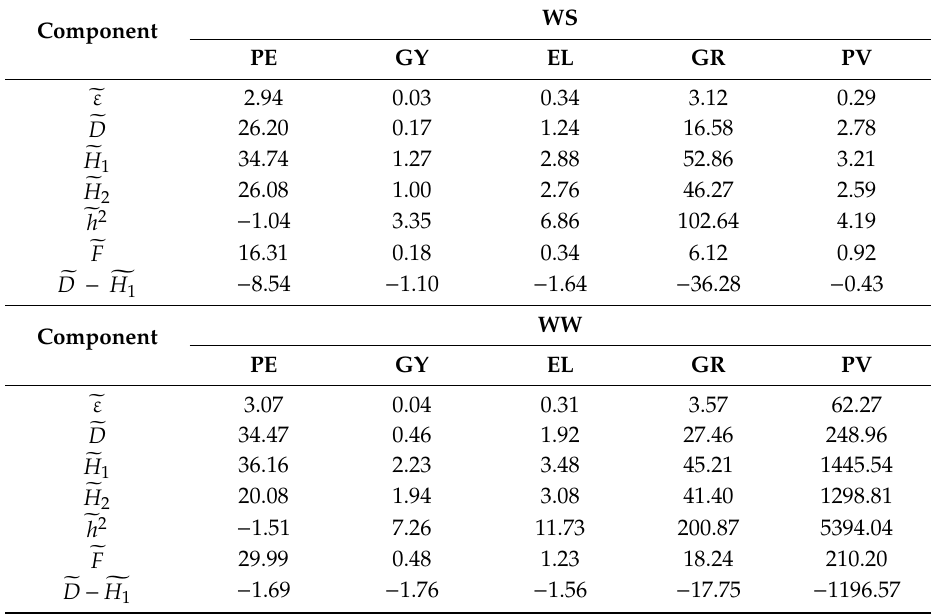
Table 5. Estimates of genetic and non-genetic components, according to Hayman’s diallel analysis (1954), of the traits evaluated in popcorn genotypes under water-stress (WS) and well-watered (WW)